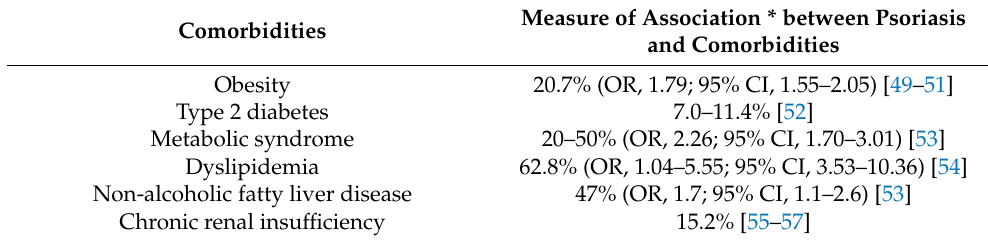
Table 3. Psoriasis comorbidities associated with an increased cardiovascular